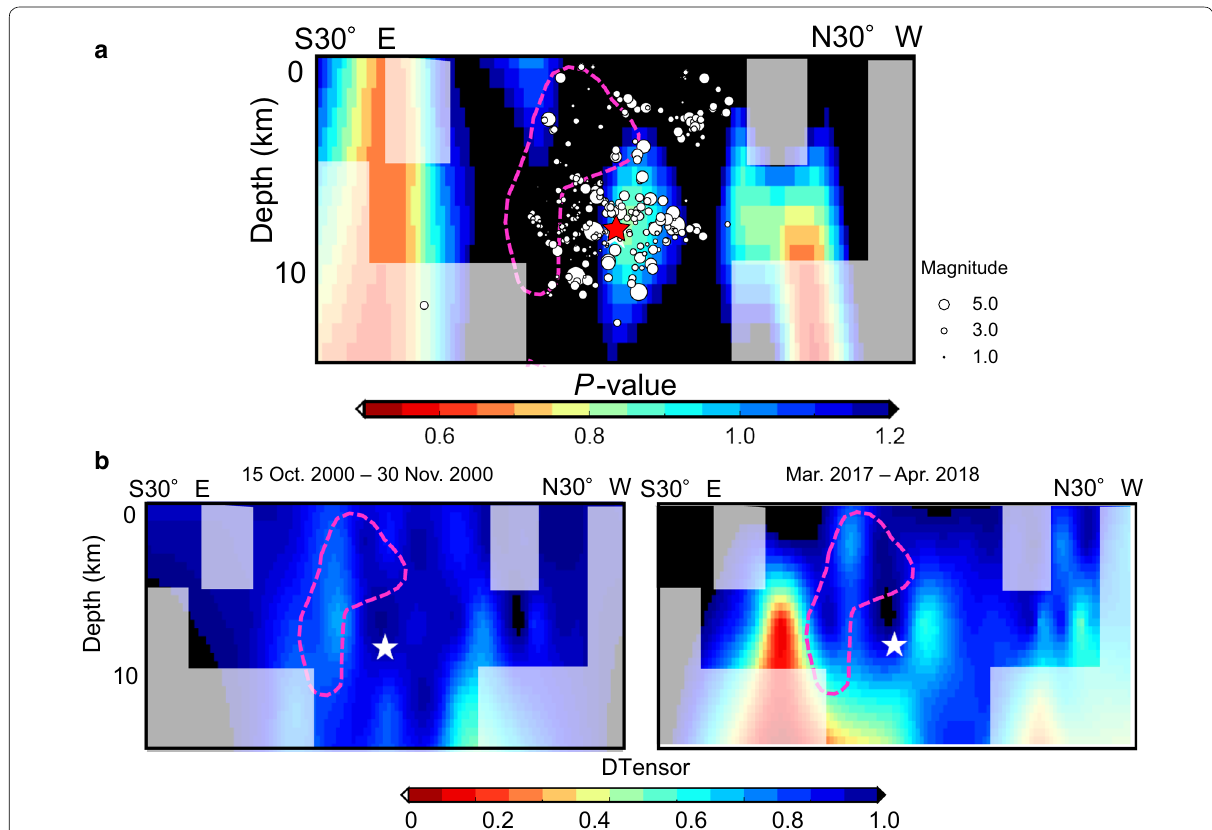
Fig. 7 a Vertical cross-section of the P value distribution along the fault plane. The shaded area shows a block where the number of moment tensors used in the analysis is less than 10 in either period (2000 or 2017). The pink dashed line indicates the contour line of co-seismic slip larger than 2.5 m, from Iwata et al. (2002). The star indicates the location of the W-Tottori EQ hypocenter. The activity that preceded the W-Tottori EQ from Shibutani et al. (2002) is plotted as open circles. b The 90% confidence interval of the inelastic strain rate distribution for the period in 2000 (left) and in 2017–2018 (right). Other symbols are the same as in Fig.